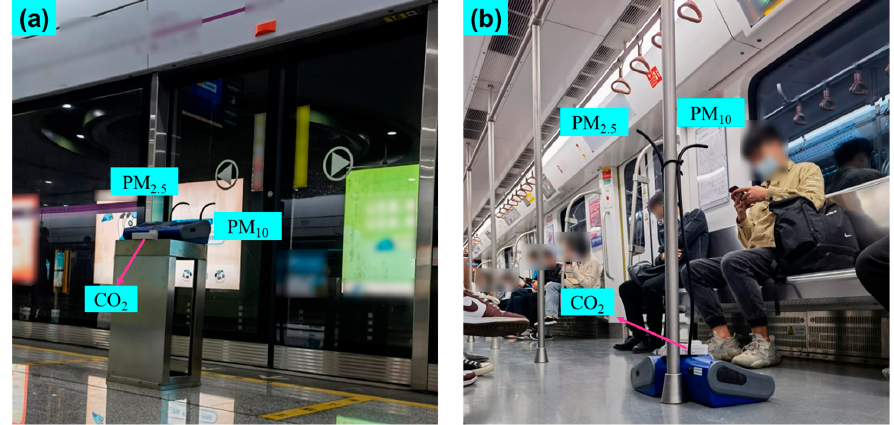
Figure 2. Field measurement conditions. ( a ) Metro platform. ( b ) Metro carriage.